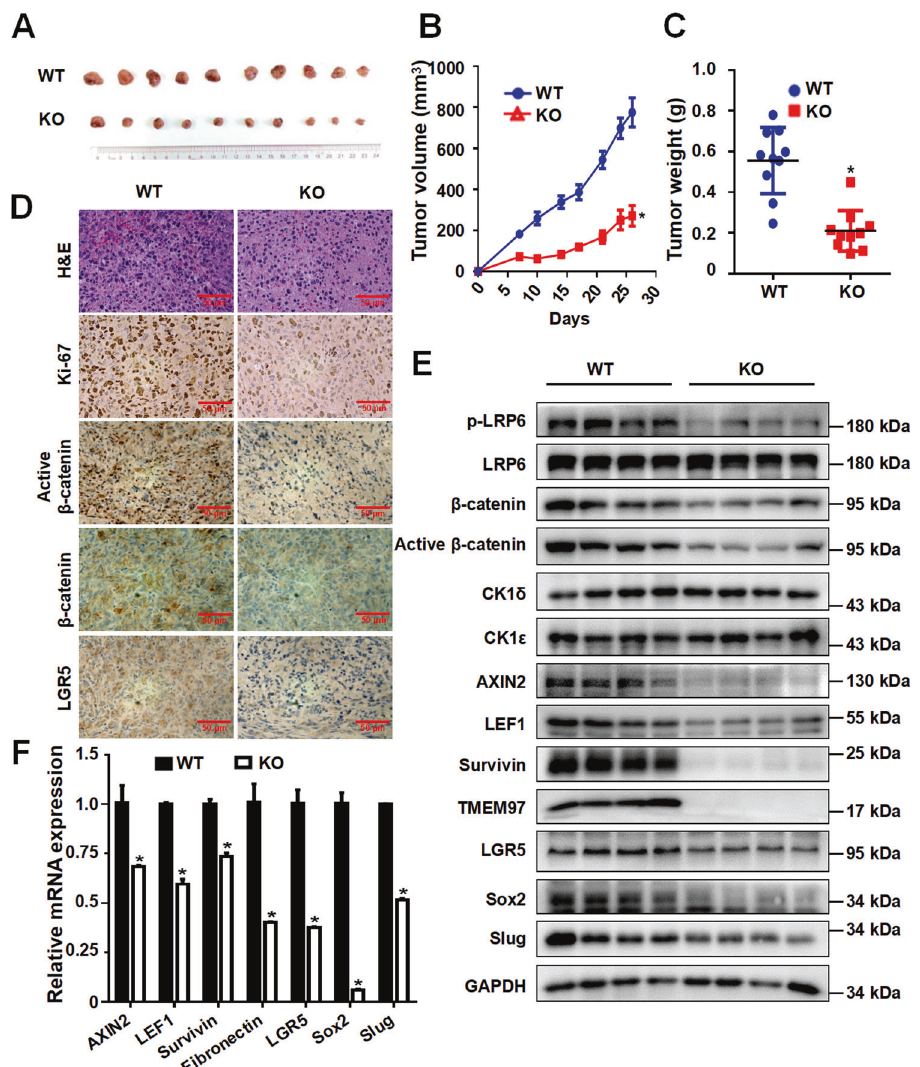
Fig. 8 TMEM97 Knockout inhibits tumor growth in vivo through downregulating Wnt/ β -catenin signaling in MDA-MB-231 cell xenografts. A Images of tumors from TMEM97 knockout group (KO) and the control group (WT). B Tumor volume. C Tumor weight. Each dot represents an individual mouse. D H&E staining, Ki-67 antibody staining, active β -catenin antibody staining, total β -catenin antibody staining, and LGR5 antibody staining. Scale bar = 50 μ m. E The protein expression levels of phosphorylated LRP6, total LRP6, active β -catenin, total β -catenin, CK1 δ , CK1 ε , AXIN2, LEF1, survivin, TMEM97, LGR5, Sox2, and Slug in tumor samples were detected by immunoblotting. The images shown are representative of data generated in at least three independent experiments. F The mRNA expression levels of AXIN2, LEF1, survivin, fi bronectin, LGR5, Sox2, and Slug were quantitated by real-time PCR. Data represent the mean ± SD ( n = 3, * P < in breast cancer cells and tissues [32]. Knockdown of LRP6 signi fi cantly inhibited Wnt/ β -catenin signaling and impaired cell proliferation and tumorigenesis in breast cancer [32]. Multiple small molecular compounds (e.g., salinomycin, prodigiosin, silibinin, rottlerin, gigantol, and CDDO-Me) have been shown to inhibit the Wnt/ β -catenin pathway and growth in breast cancer cells by acting on LRP6 [24, 33 – 37]. It has been reported that the recombinant Mesd protein and its C-terminal region peptide, two antagonists of LRP6, markedly suppressed Wnt/ β -catenin signal- ing, cell proliferation and tumor growth in breast cancer [38]. Overexpression of LRP6 in the mammary glands of mice initiated tumor formation [39]. Moreover, the tumor metastasis suppressor N-myc downstream regulated gene-1 (NDRG1) repressed Wnt/ β -catenin signaling through interacting with LRP6, resulting in suppression of metastatic phenotypes of mammary tumor cells [40]. Zhang et al showed that kallistatin, a plasma protein,